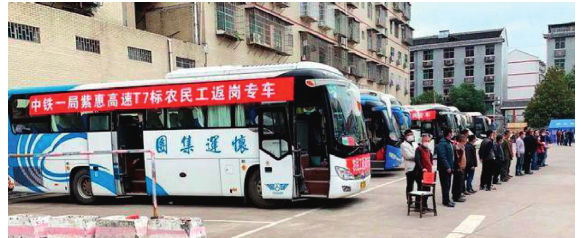
Figure 3: Chartered buses for workers returning in Case 4